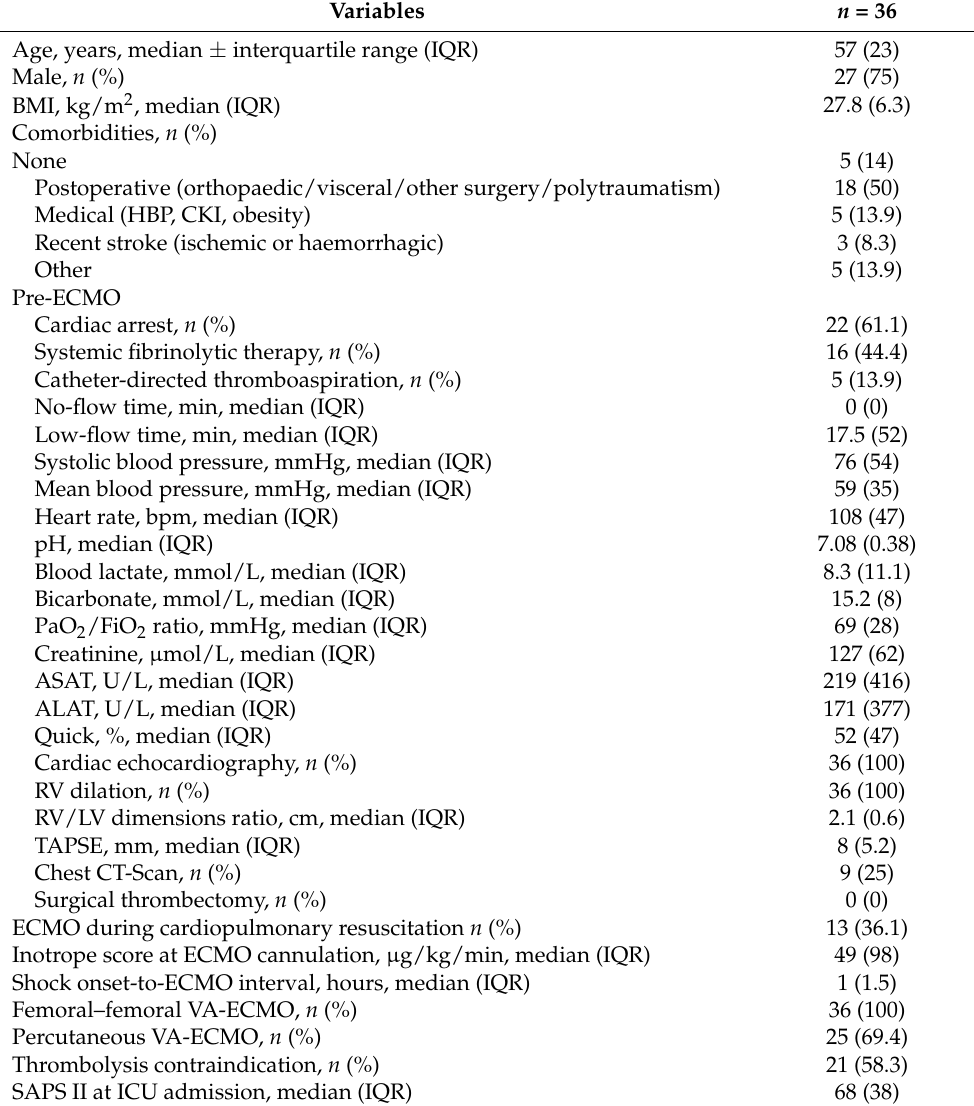
Table 1. Description of the study population. Variables n =